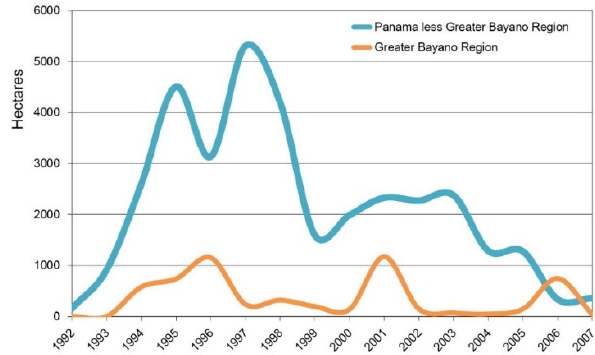
Figure 8. Annual area established in forest plantation, in hectares, for Greater Bayano Region and Panama, 1992–2007. Source: Data from Forest Registry of ANAM.